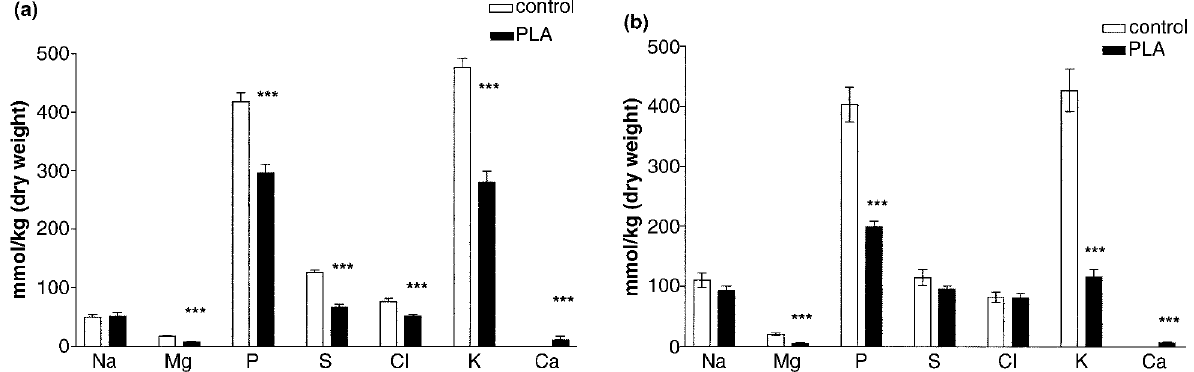
FIG. 7. X-ray microanalysis of (a) 16HBE14o– cells and (b) NHBE cells. Open bars, control; solid bars, exposed to poly- L -arginine (PLA). Significant differences between exposed cells and controls are indicated by asterisks, *** p < 0.001. Between 30 and 80 cells in each group were analyzed. Thin lines indicate standard